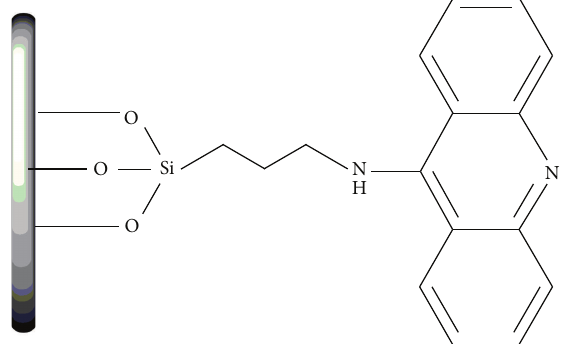
F 2: A schematic model for 9-acridinylamine modi�ed nano alumina.